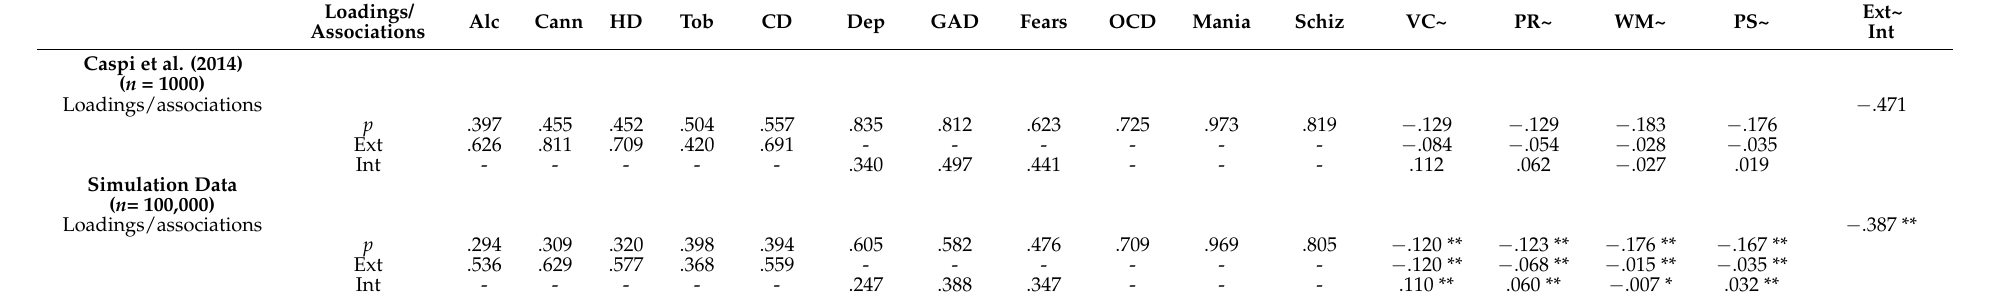
Table 1. Comparison of Loadings, Covariances, and Associations Between Caspi et al. [4] Revised Bifactor Model in the Original and Simulated Data.